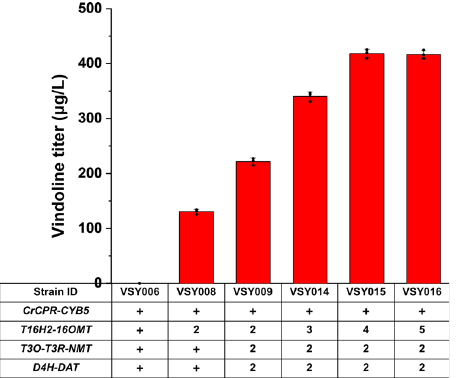
Fig. 3 Enhancing vindoline biosynthesis via increasing and tuning the copy numbers of the rate-limiting enzyme encoding genes. With VSY006 as the parent strain, additional copies of T16H2 - 16OMT expression cassettes and other pathway gene expression cassettes were introduced by CRISPR/Cas9-mediated multi-copy genome integration technology. Error bars represent SD of biological triplicates ( n =